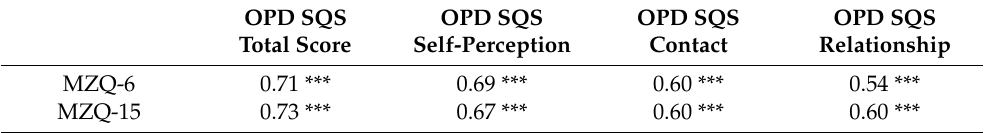
Table 3. Correlations of MZQ-10 and MZQ-15 total score with OPD-SQS total score and subscales. OPD SQS OPD SQS Total Score